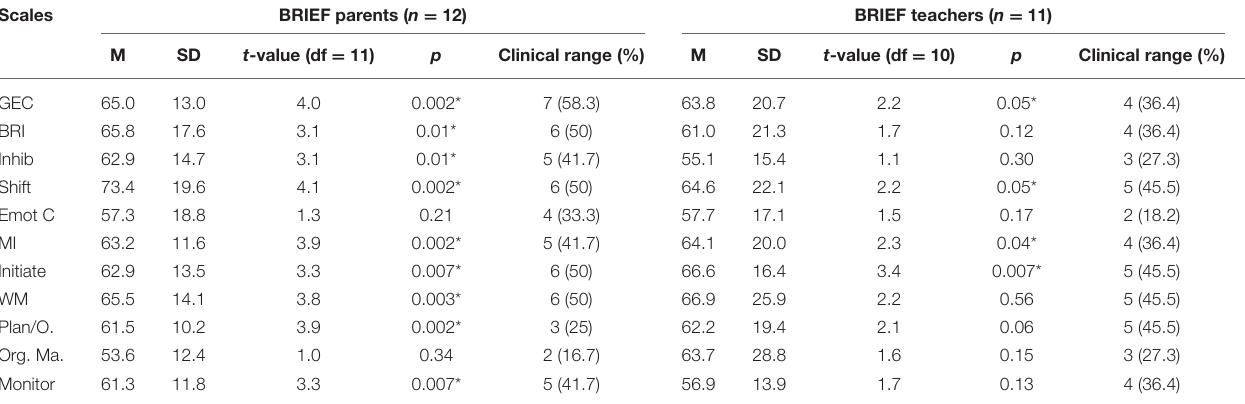
TABLE 3 | BRIEF parent and teacher results in the whole clinical group compared with normative data. Scales BRIEF parents ( n =